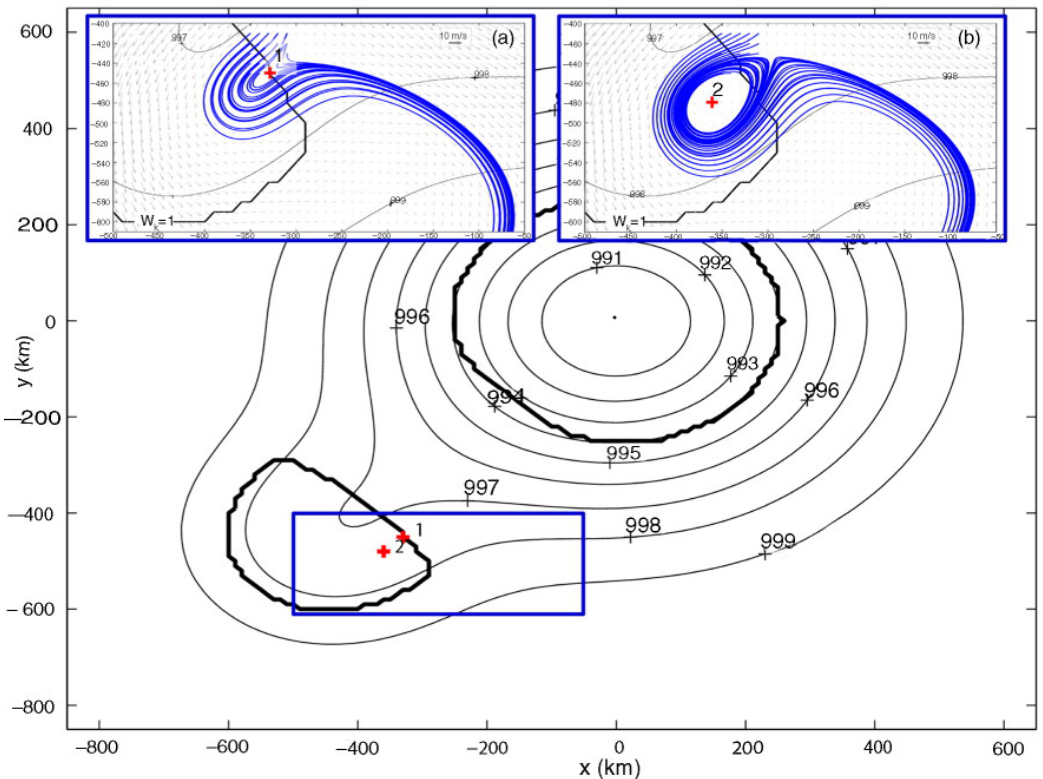
Figure 1. Horizontal streamline patterns around two points labeled 1 and 2 with different W k values in a field of two superpositioned low pressure systems. Thin black contours are isobars, and thick black contours are equal to W k = 1. The blue box indicates the region plotted in the insets. ( a ) Streamlines (blue) around Point 1 with W k = 1 at the vortex core boundary, and ( b ) streamlines (blue) around Point 2 with W k > 1 inside the vortex core. Gray arrows are the horizontal wind vectors around 1 and 2,